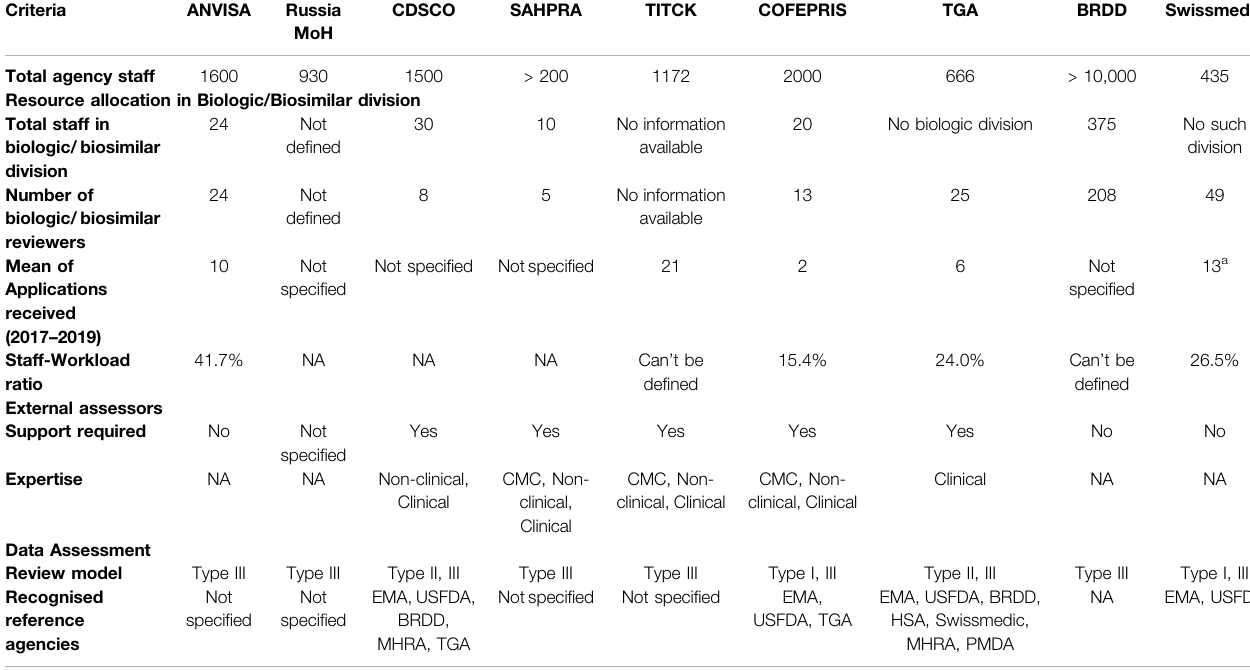
TABLE 1 | Comparison of organisational structure and review